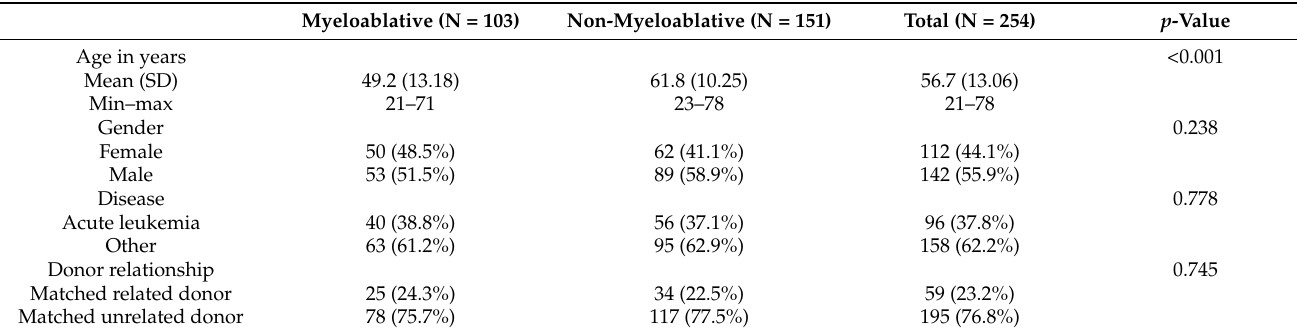
(Figure S1). The gender, underlying disease distributions and fraction of related donors were similar between the two conditioning regimens (Table 1). The mean age was signifi- cantly lower for the myeloablative group than for the non-myeloablative group (Table 1). For the post-aHSCT samples, the mean number of days of antibiotic prescriptions in the last 100 days prior to sampling was larger for the myeloablative than for the non-myeloablative group (Wilcoxon, p < 0.01, Figure S2). Table 1. Patient characteristics.